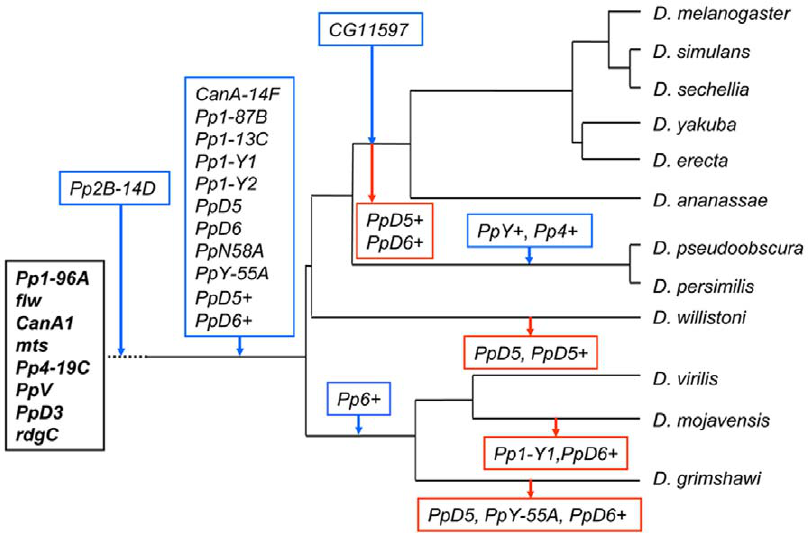
Figure 4. Gain and loss of PPP genes in Drosophilidae . The basic PPP set of insects is in a black box. Gained genes are in blue and lost genes are in red boxes. The broken line indicates that the Pp2B-14D gene was gained in the Diptera . The family tree of the 12 Drosophila species with a mutational clock is presented in Figure S1A .